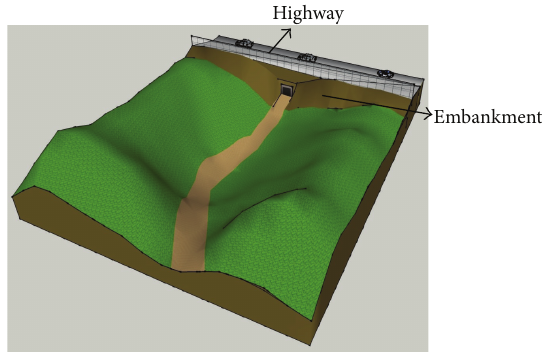
Figure 1: Topographic map of area surrounding